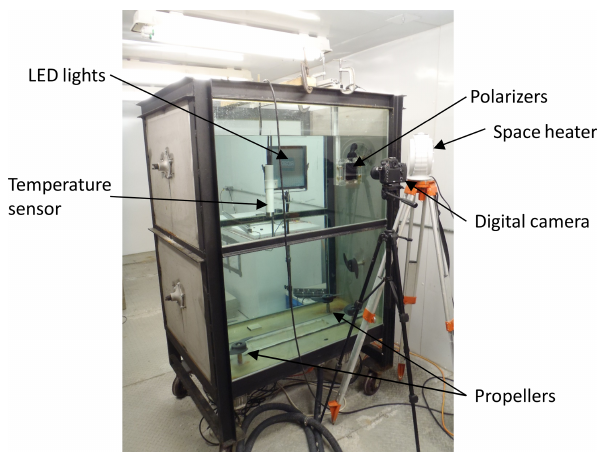
Figure 1. Frazil ice tank experimental